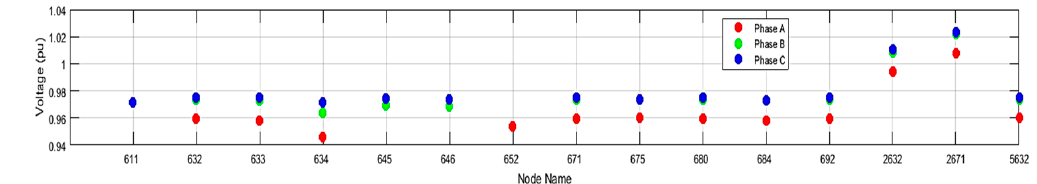
Figure 14. Voltage magnitude across all nodes at the last restoration step.